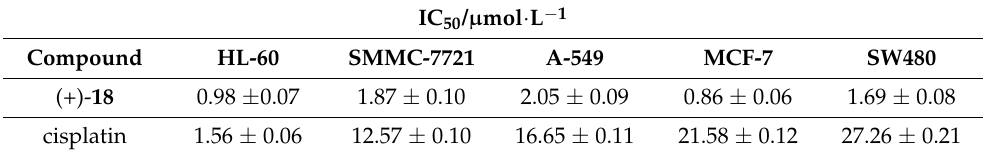
Table 3. Values of the minimal inhibitory concentration (MIC) ( µ g/mL) of (+)-stemodin ( 1 ) and (+)-stemodinoside B ( 15 ) [6]. ND = not determined. Bacteria (+)-1 (+)-15 Staphylococcus aureus (ATCC 12692) 512 ≥ 1024 Staphylococcus aureus (ATCC 6538) ND 512 Staphylococcus aureus (ATCC 358) 512 ND Staphylococcus aureus (ATCC 12624) ND ≥ 1024 Pseudomonas aeruginosa (ATCC 15442) 512 512 Bacillus cereus (ATCC 33018) 512 ≥ 1024 Escherichia coli (ATCC 27) 512 ≥ 1024 Escherichia coli (ATCC 25922) ≥ 1024 512 Aeromonas carveae (ATCC 15468) ND ≥ 1024 Klebsiella pneumoniae (ATCC 10031) ND 256 Shigella flexneri (ATC 12022) ND 512 Vibrio cholerae (ATCC 15748) ND ≥ 1024 Listeria monocytogenes (ATCC 7644) ND 256 Table 4. Values of IC 50 / µ mol . L − 1 of (+)-trigoheterone A ( 18 )